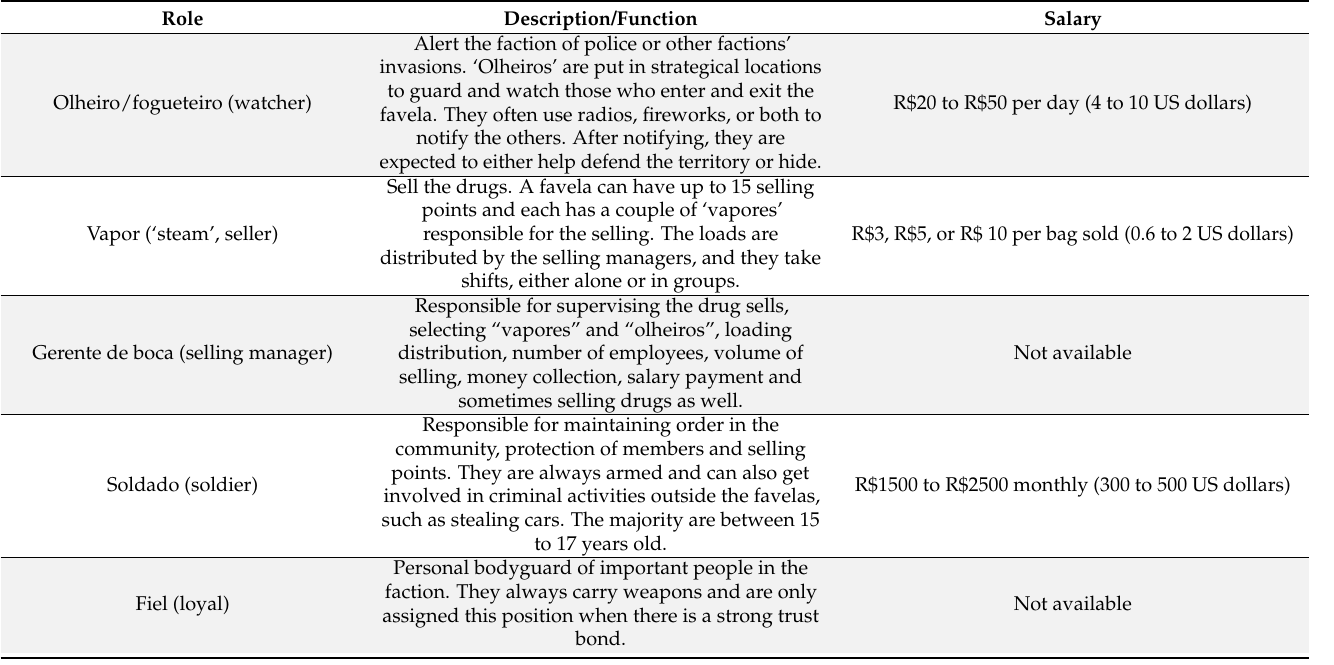
Table 2. Different Roles Children and Adolescents Have in Factions